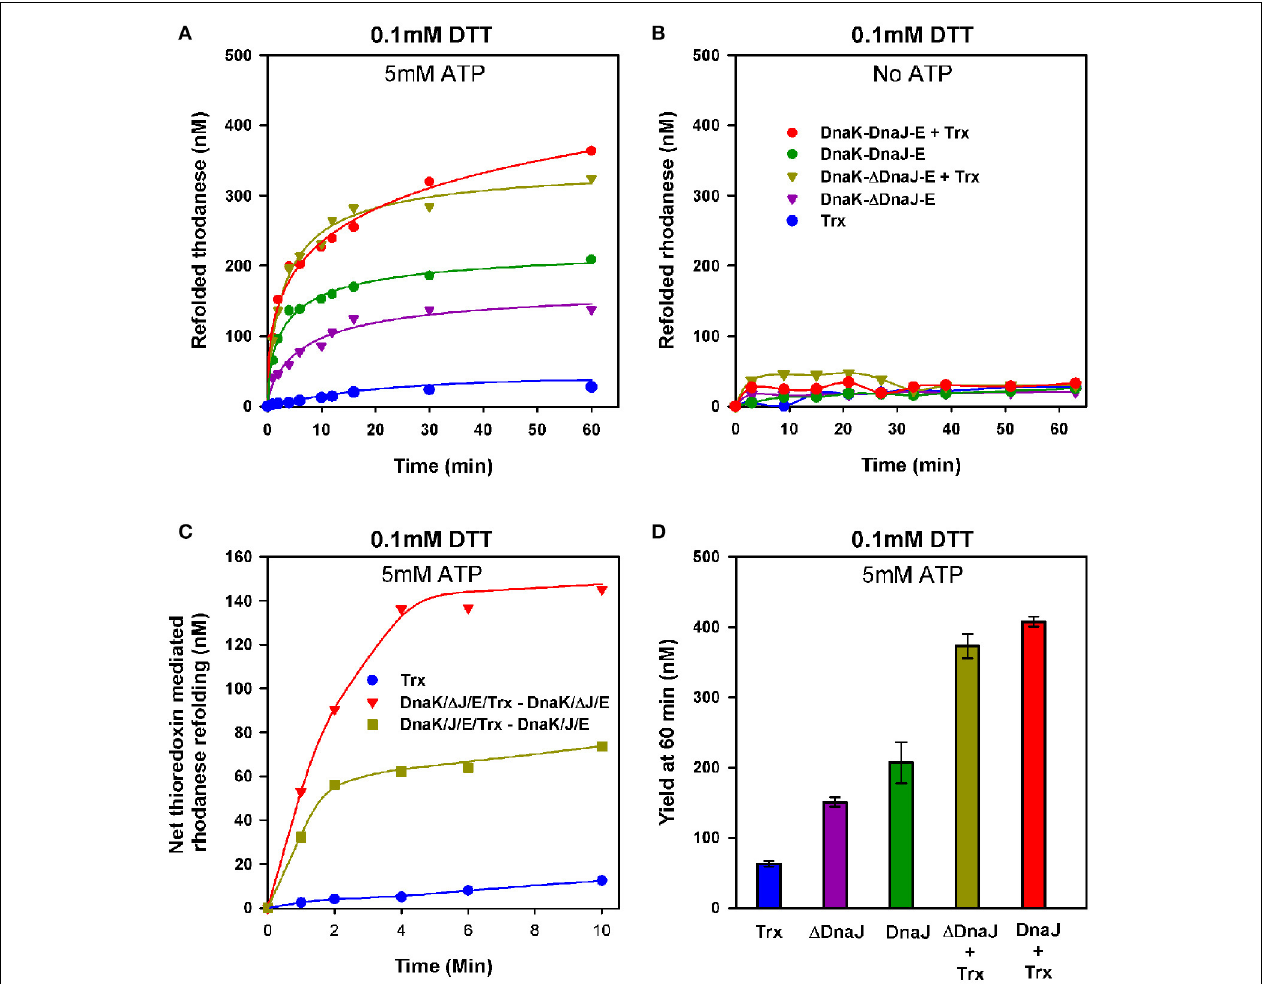
FIGURE 4 | Thioredoxin-1 enhances unfolding of oxidized polypeptide substrates by DnaK. (A) Urea inactivated rhodanese (0.5 μ M) was refolded at 25 ◦ C, under limited amounts of DTT (0.1mM), without or with 3 μ M DnaK, 1.6 μ M DnaJ or (cid:2) DnaJ, 1 μ M GrpE and 5mM ATP in absence or presence of 1 μ M Thioredoxin